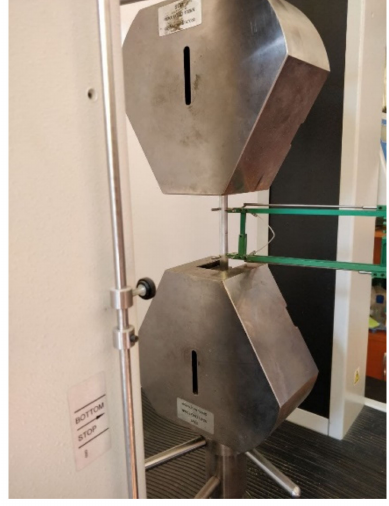
Figure 2. The tensile test.